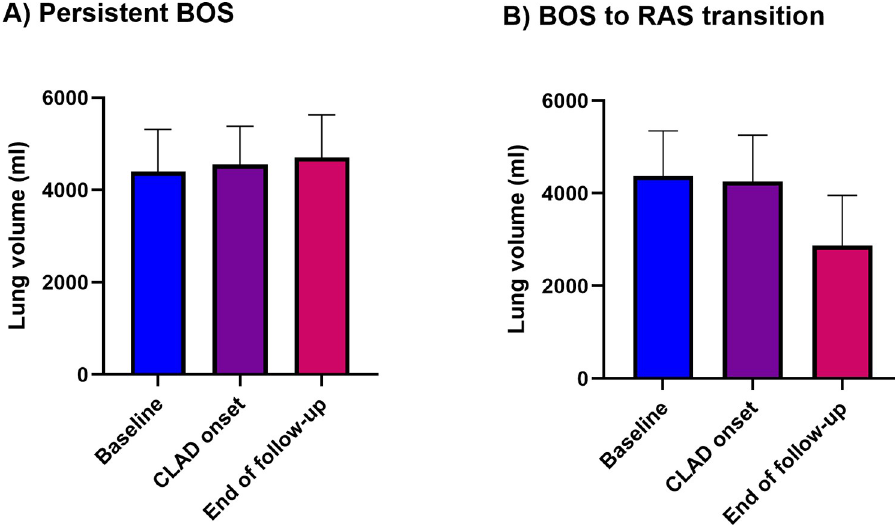
Fig 2. Lung volume progression during follow-up. A) Lung volume during follow-up for persistent BOS, B) lung volume during follow-up for BOS-to-RAS transition. Data presented as median with interquartile range. BOS: Bronchiolitis obliterans syndrome; CLAD: Chronic lung allograft dysfunction; RAS: Restrictive allograft syndrome.